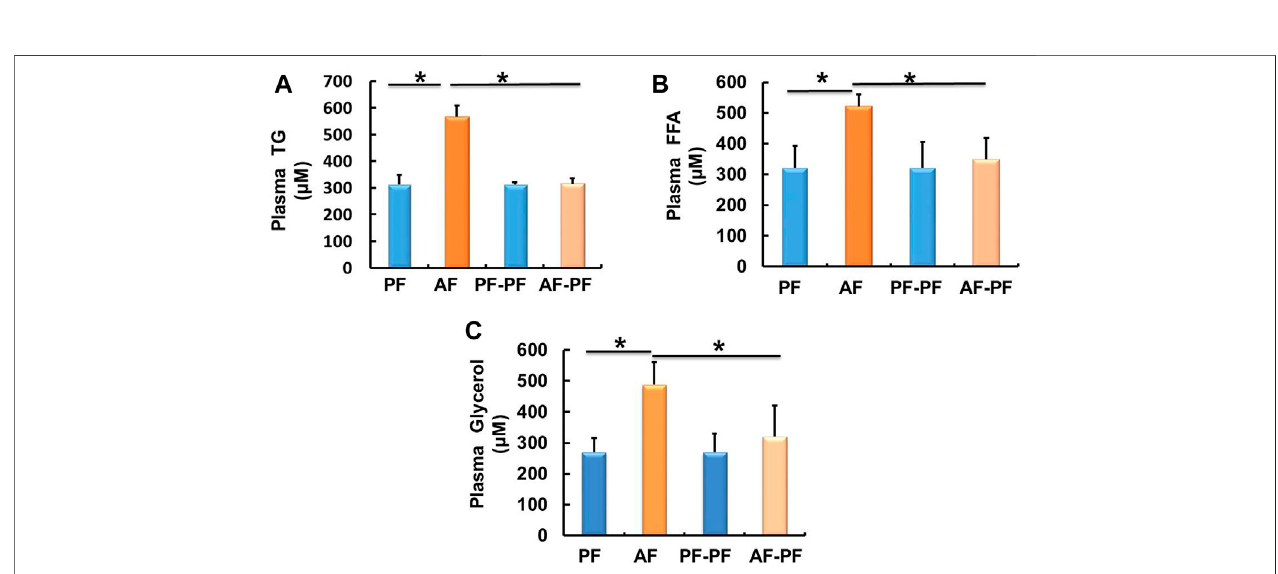
FIGURE2| Alcoholwithdrawalalleviatesalcohol-induceddyslipidaemia. (A) Plasmatriglyceride(TG)level. (B) PlasmaFFAlevel. (C) Plasmaglycerollevel.Dataare described as means ± SD from 8 mice in each group. * p < 0.05 indicates statistically signi fi cant differences ( n (cid:1) 8).